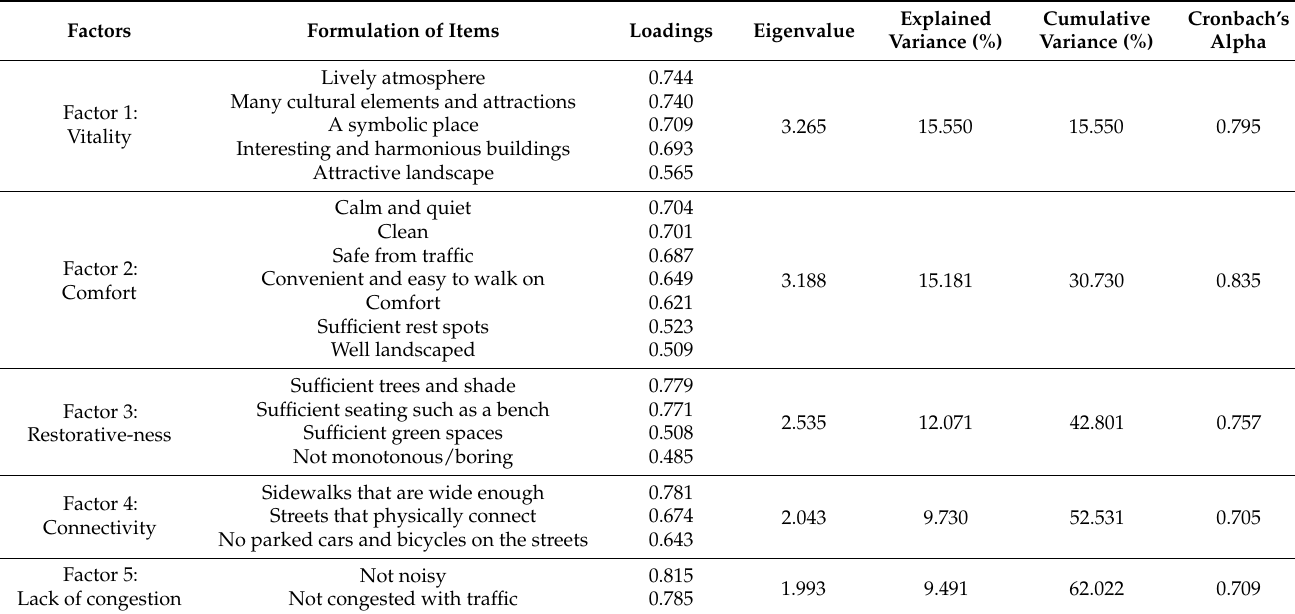
Table 5. The factor analysis of the perceived environment